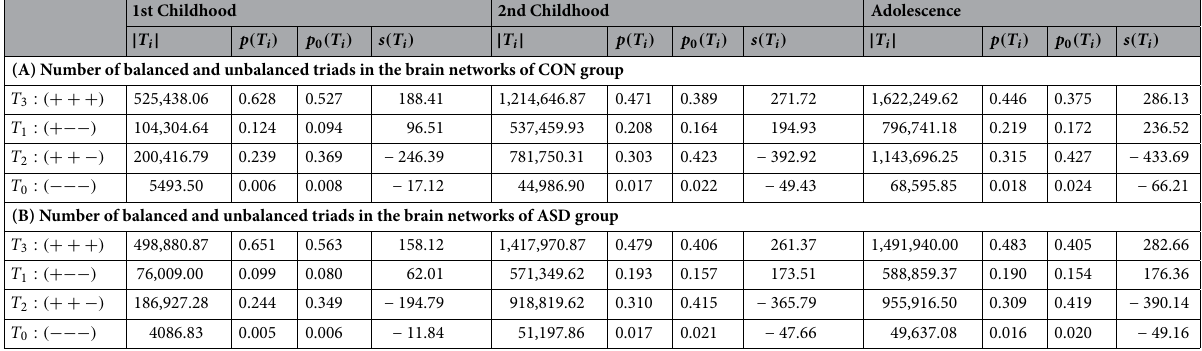
Table 1. Number and probability of triads in the brain networks compared to the null model. On average, in both CON and ASD groups, both types of balanced triads, T 3 and T 1 , are overrepresented (positive s ( T i ) ), while both types of unbalanced triads, T 2 and T 0 , are underrepresented (negative s ( T i ) ). | T i | , total number of T i ; p ( T i ) , fraction of T i in the brain network; p 0 ( T i ) , fraction of T i in the null model; s ( T i ) , the amount of surprise, i.e., is the number of standard deviations by which the actual number of T i differs from its expected number under the null model; CON, control; ASD, autism spectrum